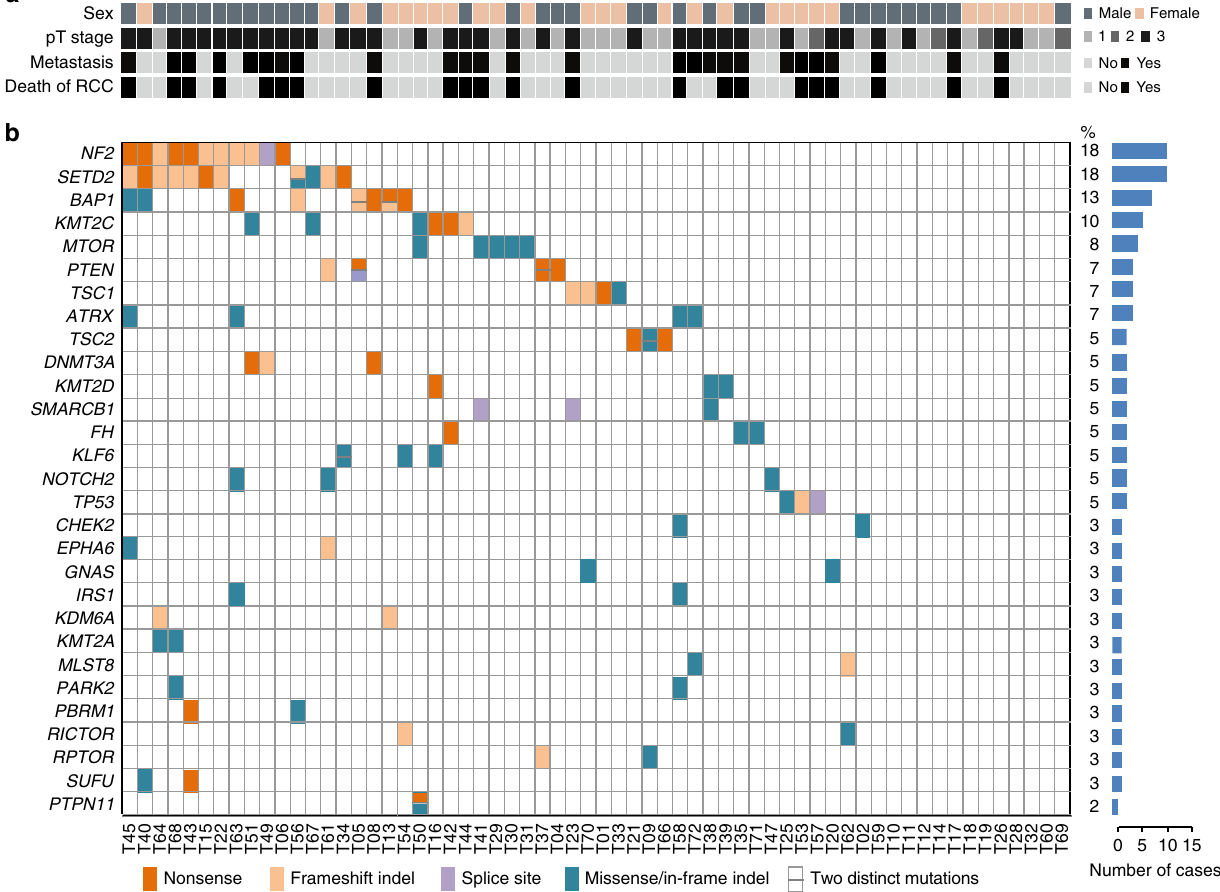
Figure 1 | Recurrent somatic mutations identified in high-grade uRCC. ( a ) Key clinicopathological characteristics of our 62-patient uRCC cohort. Pathological (pT) stage was determined according to the 7th edition of the American Joint Committee staging system for renal cancer. The status of metastasis for individual patients was determined at their last follow-up visits or death. ( b ) Mutational landscape of recurrent somatic mutations based on IMPACTassays. Mutated genes are listed on the left, and denoted by individual rows. Sixty-two individual patient tumours are presented as columns and labelled at the bottom (T#). Mutation frequency (%) and absolute number of cases with non-silent mutations detected on individual genes are listed on the right. Mutation frequency was calculated as the percentage of individual tumours with mutation(s) in the indicated